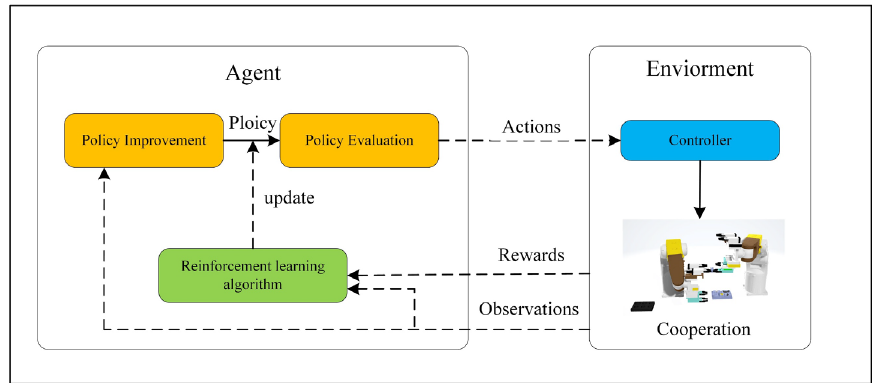
Figure 11. Reinforcement learning mechanism.